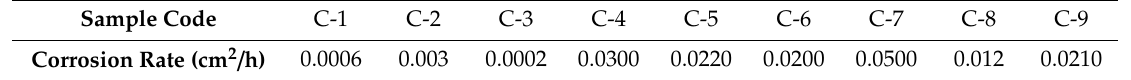
Table 5. Corrosion rates of samples tested in the CASS